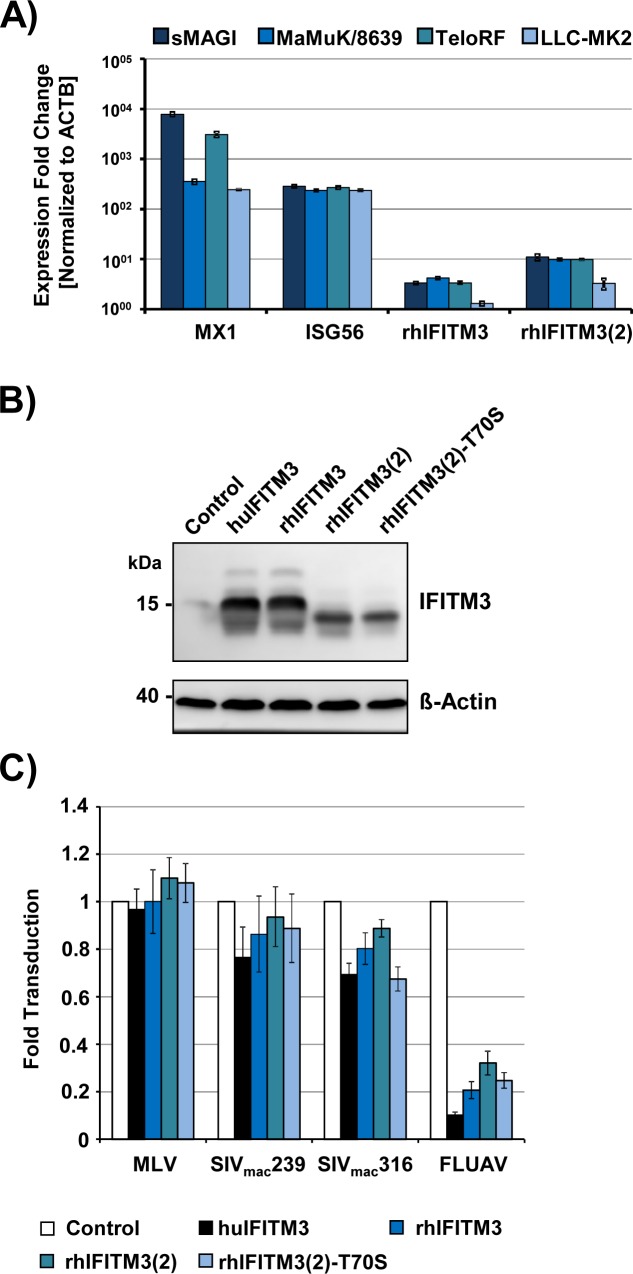
rhIFITM3(2) exerts antiviral activity.(A) The indicated rhesus macaque cell lines were incubated in the presence of pan-IFNα (IFN, 100 U/ml, 24 h) or control-treated, before transcript levels for ß-actin (ACTB), MX1, ISG56, rhIFITM3 and rhIFITM3(2) were analyzed by quantitative RT-PCR and normalized against transcript levels for ß-actin (reference gene). Differences in the relative number of MX1, ISG56, rhIFITM3 and rhIFITM3(2) transcripts between IFN-stimulated and control (mock)-treated cells were calculated by the 2-ΔΔCt-method [35] including normalization against ACTB (housekeeping gene control) levels, and are shown as expression fold change. The results of a single experiment performed with triplicate samples are shown and were confirmed in a separate experiment. Error bars indicate the standard deviation. (B) 293T cells were transduced to express the indicated IFITM proteins and expression was detected by immunoblot using a polyclonal antibody raised against human IFITM2. Expression of β-actin served as loading control. Similar results were obtained in three independent experiments. (C) 293T cells were transfected to express rhesus macaque CD4 and CCR5 genes and then transduced to express either control (chloramphenicol-acetyltransferase, Cat), human (hu) and rhesus macaque (rh) IFITM3 or rhIFITM3(2) genes as indicated. Cells were subsequently transduced with MLV particles encoding luciferase and bearing the indicated viral glycoproteins. Luciferase activities in cell lysates were determined at 72 h post transduction. The average of six independent experiments is shown. Luciferase activities measured in control cells were set as 1. Error bars indicate standard error of the mean.